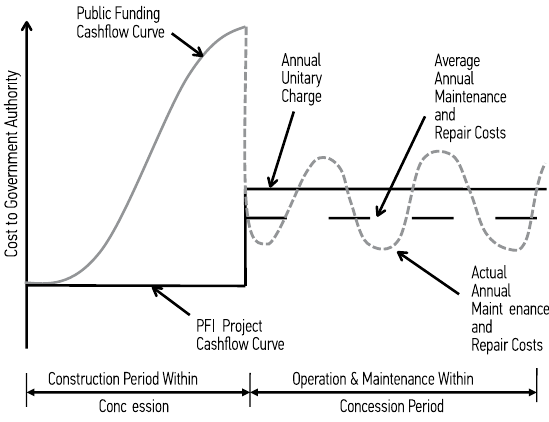
Fig. 1. Notional revenues and costs for a PFI road project (Akbiyikli et al. 2011)